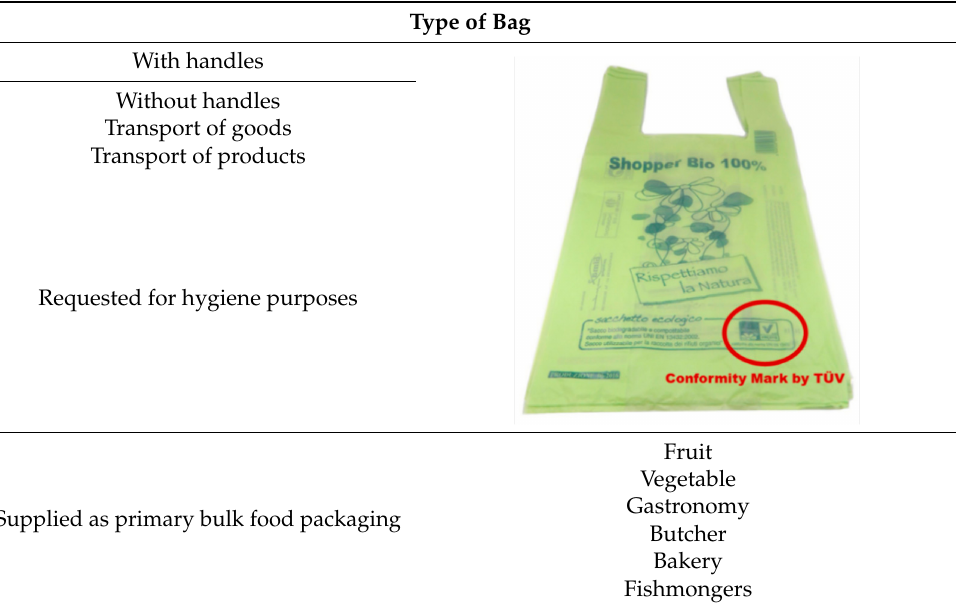
Table 1. Main types of polymer-based bags to which the new legislation [12]